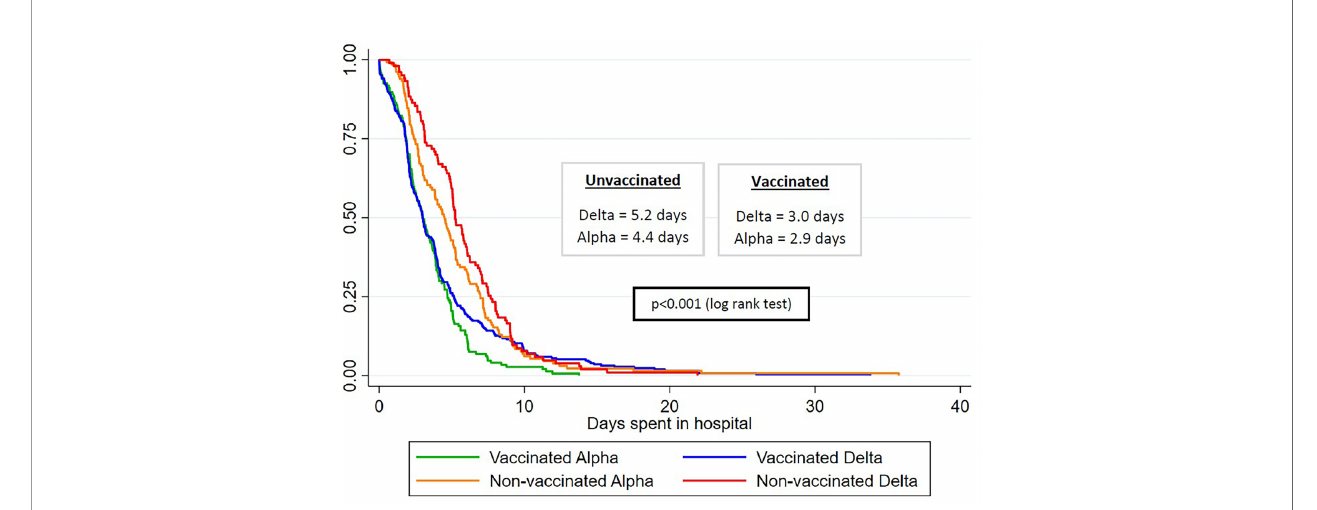
FIGURE 2 | Median length of hospital stay by variant type and vaccination status.